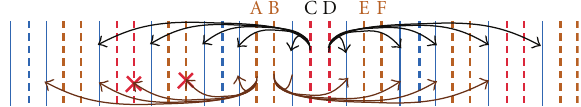
Figure 16: Coulomb transitions of nearest hole pairs at ν = 4 /